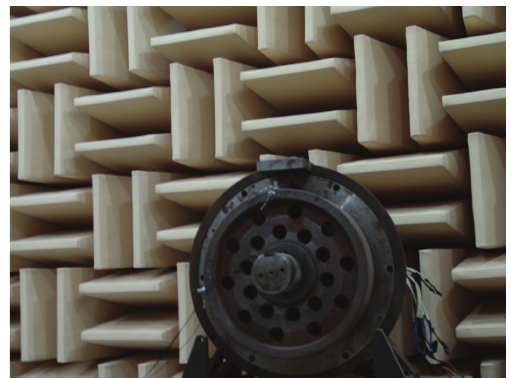
Figure 10: Experiment of 15kW motor.